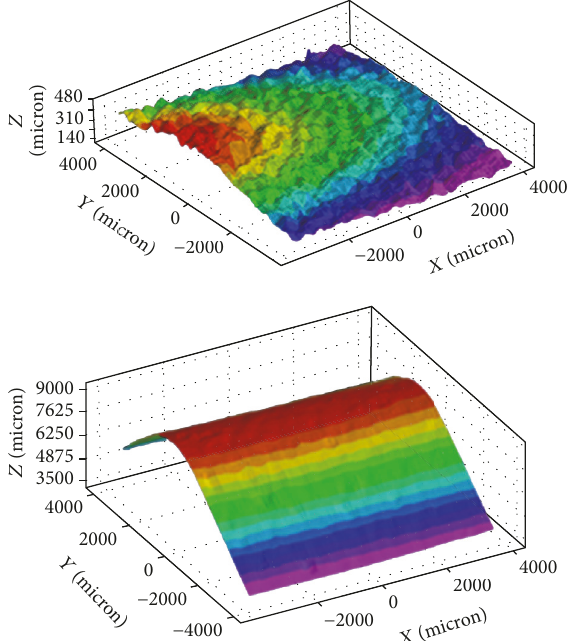
Figure 19: DIC: First and last step-3D plot-side delamination specimen.